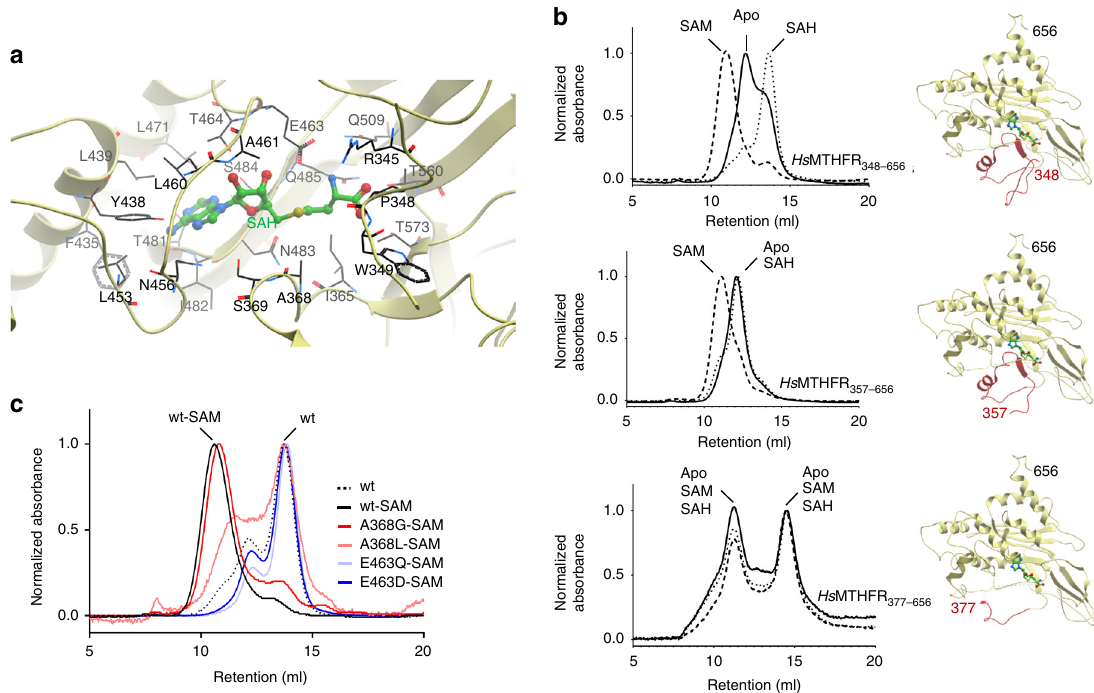
Fig. 7 SAH/SAM binding and conformational change. a The SAH binding site. Amino acids that contribute to binding are labelled and shown in black sticks. SAH is shown in green sticks. b Size exclusion chromatography of Hs MTHFR with various N-terminal truncations following incubation with SAM (dashed lines), SAH (dotted lines), or buffer (apo; solid line). For each N-terminally truncated construct, the corresponding structure is shown. c Size exclusion chromatography of Hs MTHFR 348 – 656 proteins without (wt) or with (wt-SAM) pre-incubation with SAM. Mutated Hs MTHFR 348 – 656 proteins were